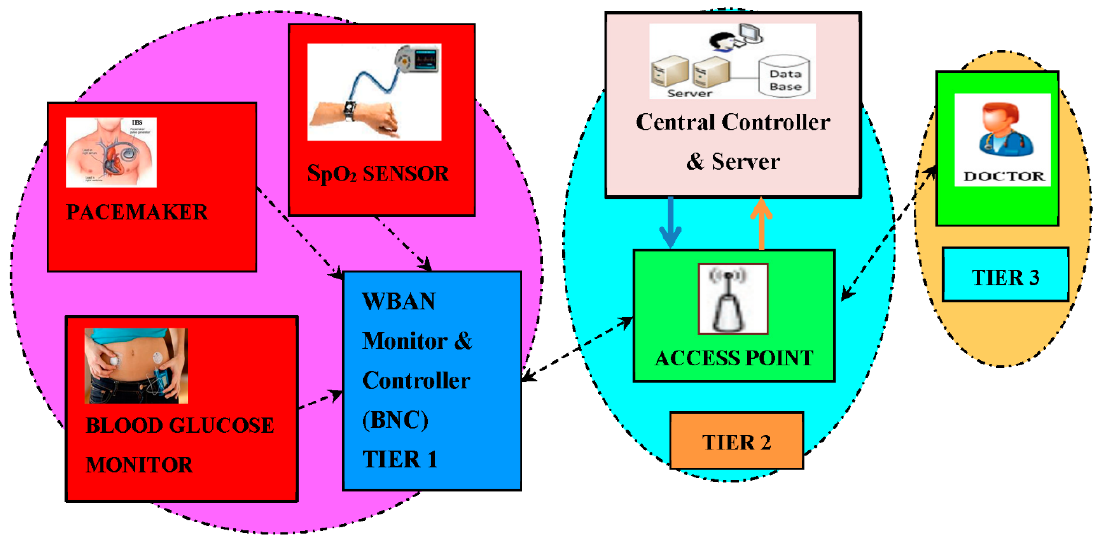
Figure 4. Three-Tier WBAN architecture.